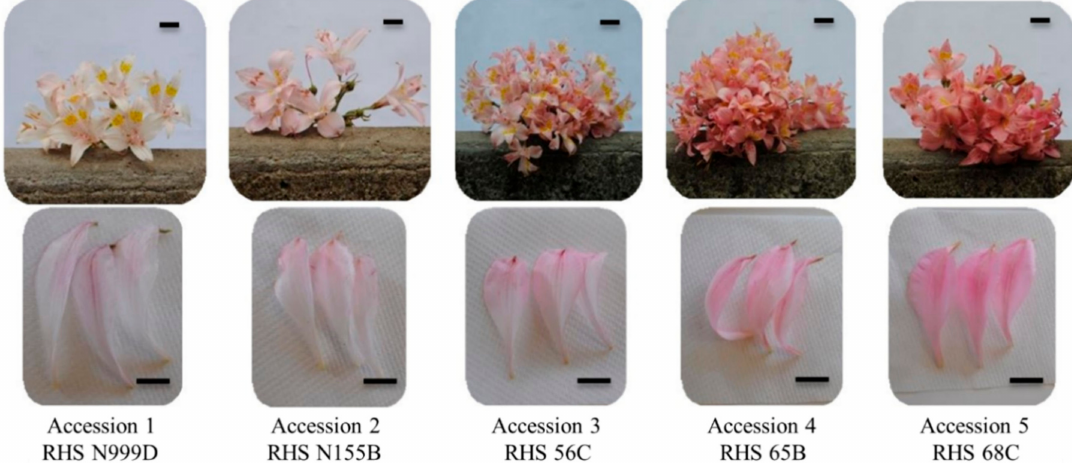
Figure 5. Flowers ( upper row ) and tepals ( lower row ) of five accessions of Alstroemeria pallida , classified by flower colour according to the RHS mini colour chart. Scale bar = 2